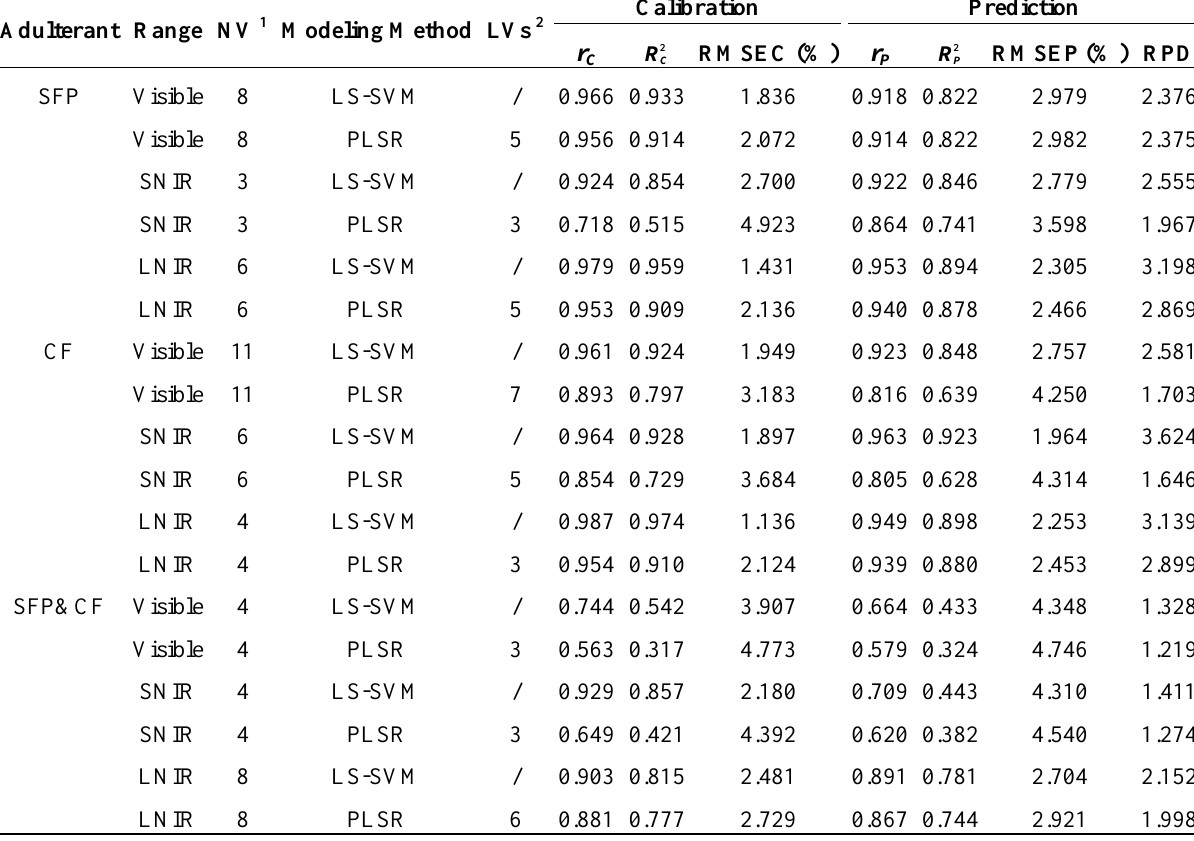
Table 4. Results of regression models for the quantification of notoginseng powder (NP) adulterated by Sophora flavescens powder (SFP), corn flour (CF), and the mixture of two adulterants using partial least squares regression (PLSR) and least-squares support vector machines (LS-SVM) algorithm based on the spectra at the competitive adaptive reweighted sampling (CARS) selected wavelengths of visible spectra, short-wave near infrared spectra (SNIR), and long-wave near infrared spectra (LNIR),